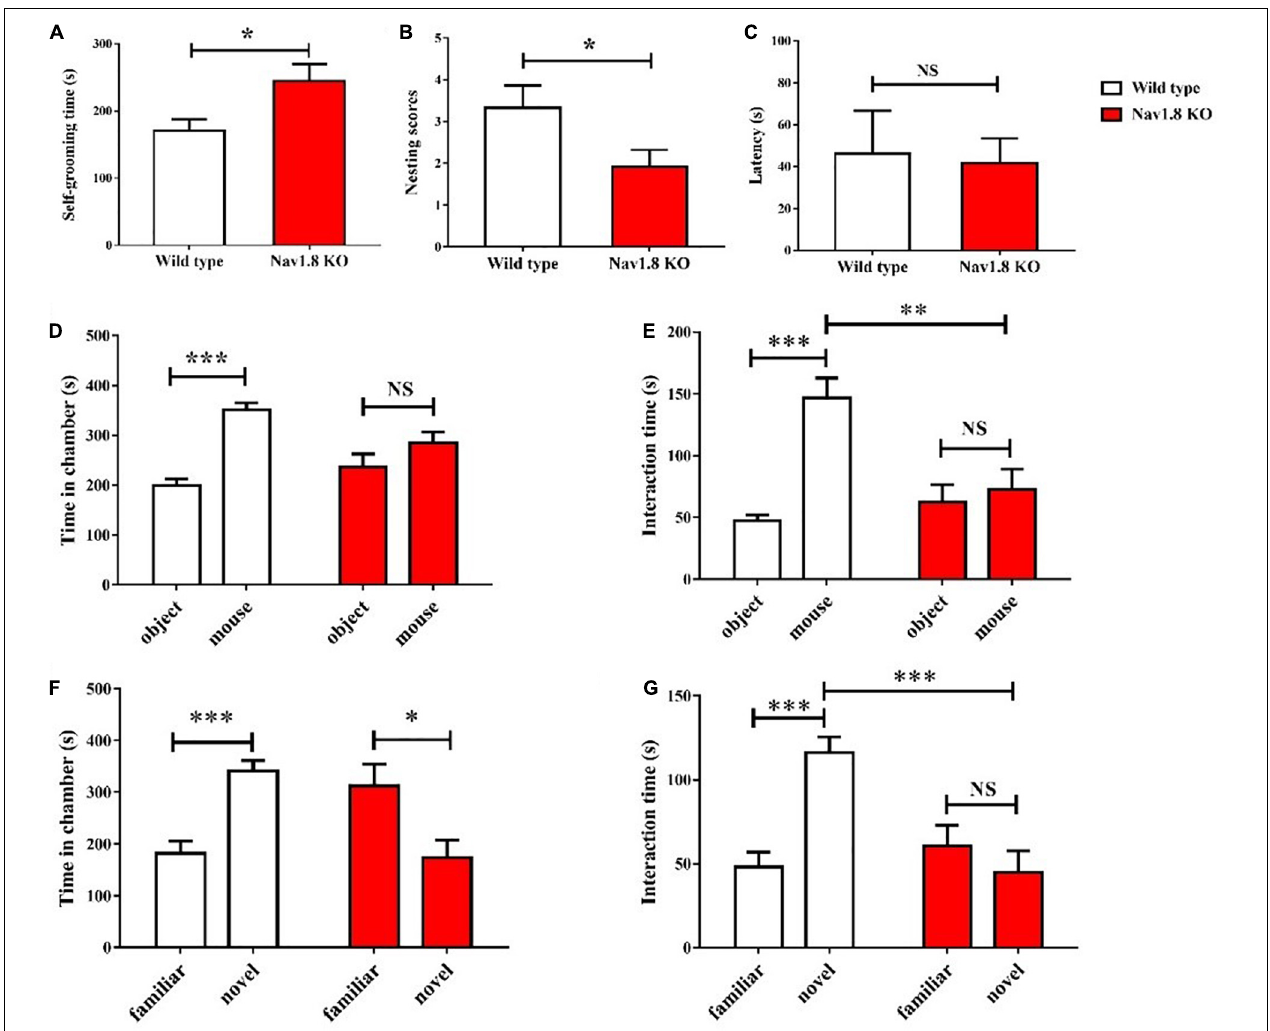
FIGURE 7 | ASD-related behavioral tests in Na v 1.8 knockout mice. (A) Self-grooming test. Increased self-grooming time in Na v 1.8 knockout mice. (B) Nest building test. Na v 1.8 knockout mice had a poor score in nest building. (C) Buried-food finding test. There were no differences in the latency to find a buried food pellet between wild type mice and Na v 1.8 knock-out mice. (D–G) Three-chamber social test. Na v 1.8 knockout mice showed a lack of preference for social (mouse) and non-social (object) stimuli and a lack of preference for novel stimuli. n = 12 (A,B) and n = 9 (C–G) mice per group. * p < 0.05, ** p < 0.01, *** p <